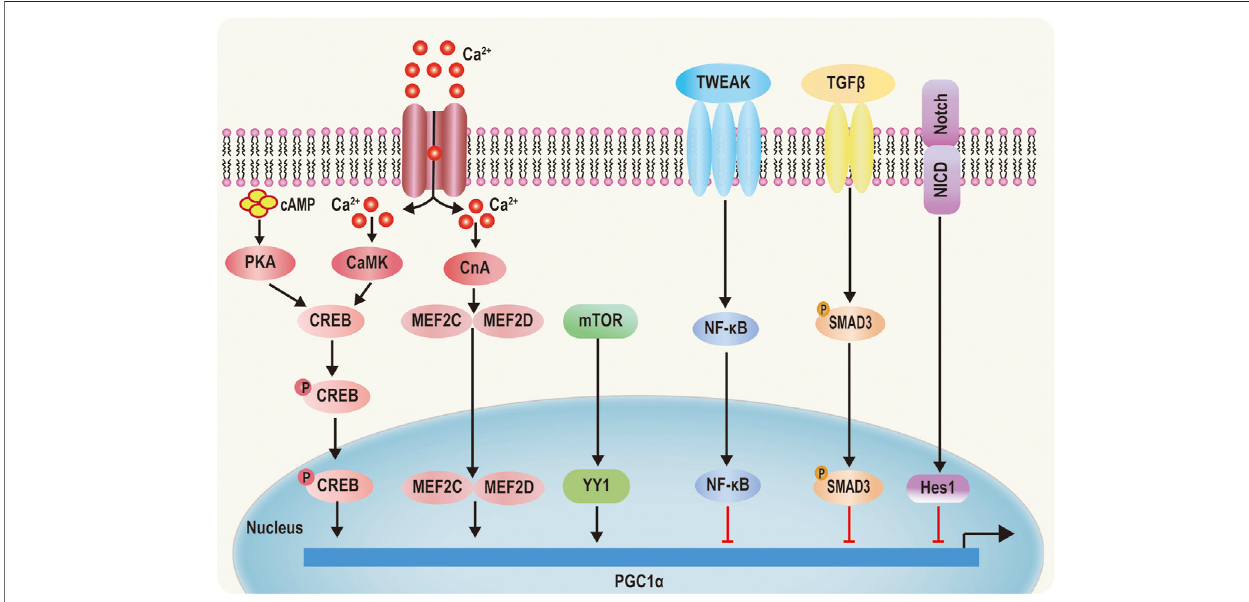
FIGURE3| TranscriptionalregulationofPGC-1 α .1)PKAisactivatedbycyclicAMP(cAMP)andCaMKIVisactivatedbyCa 2+ signalingphosphorylateCREB,which